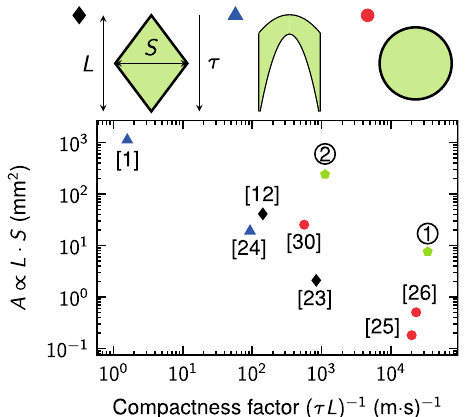
Fig. 4 Sensor comparison. Comparison of the effective area A enclosed by the interferometer arms as a function of the compactness factor ( τ · L ) − 1 , the inverse of the product of interferometer duration τ and baseline L . In principle, the area increases linearly with the maximum separation S and the baseline L . For high compactness and large Sagnac areas, it is advantageous to reach large separations S in short times τ at a balanced baseline L . The presented experiments employ either Mach – Zehnder-type topologies (black diamonds) 14,25 , butter fl y geometries (blue triangles) 1,26 , or ring-shaped guides (red circles) 27,28,33 . Green pentagons depict our twin-lattice interferometer in the current ① ( τ = 12.1 ms, K = 408 ℏ k )